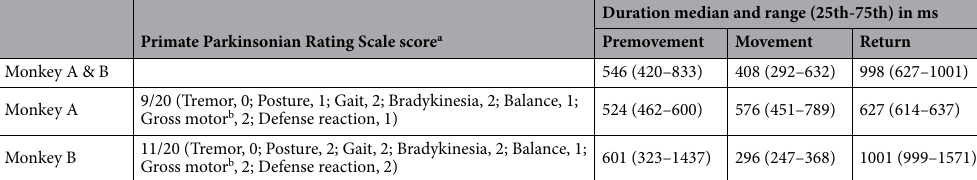
Table 1. Primate parkinsonian rating scale score and durations of the task periods of parkinsonian monkeys in DBS-OFF. The durations of Premovement, Movement, and Return periods were expressed as median and range (25th-75th percentile) in ms. a Rated on the side contralateral to the carotid artery injection of MPTP. Maximum score (20) indicating worst possible symptoms. b Gross motor skill in the upper limb.